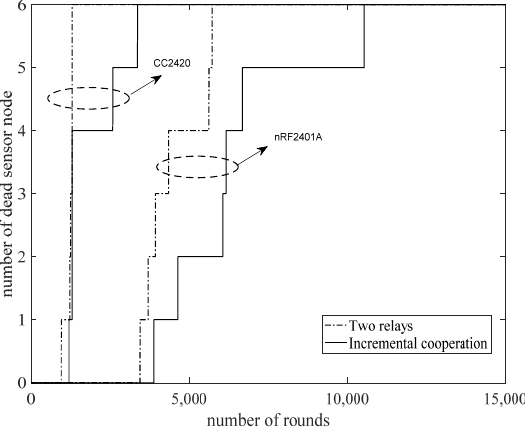
Figure 12. The relationship berween the number of dead nodes and network lifetime.